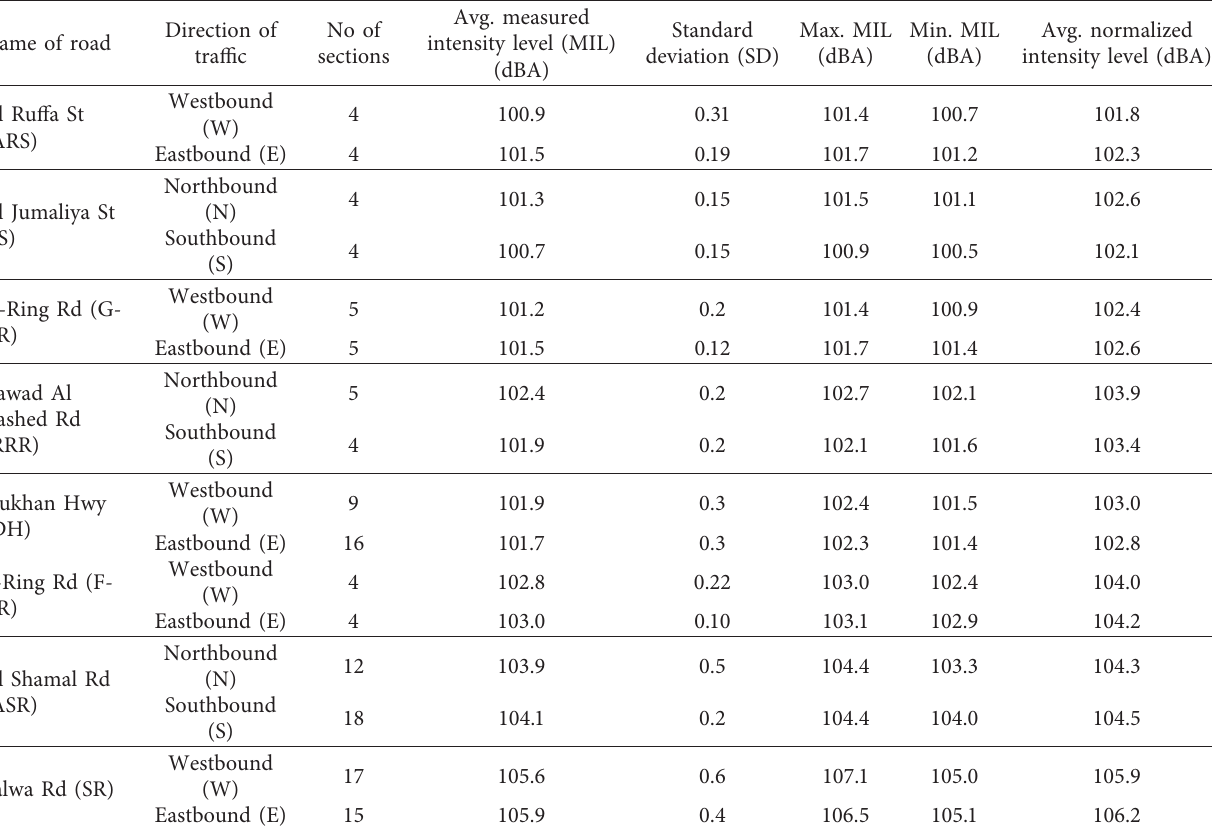
Table 3: Sound intensity level for different DGA